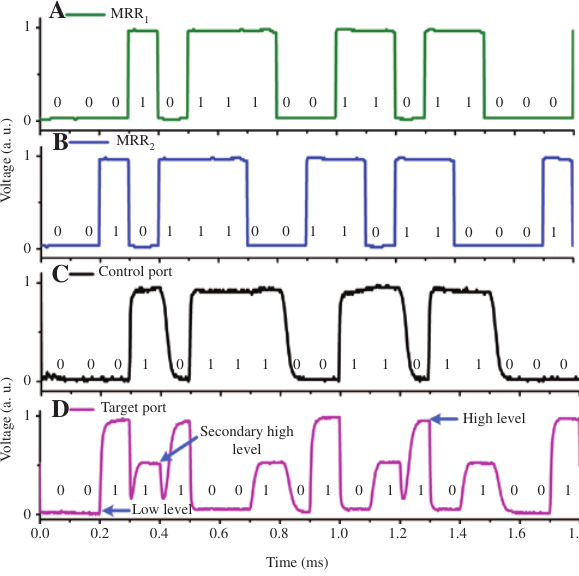
, MRR , being (A) 0 V 1 2 Figure 5: Dynamic experiment results of this device. (A) Signals applied to MRR